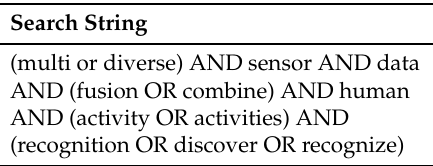
Table 2. Search string